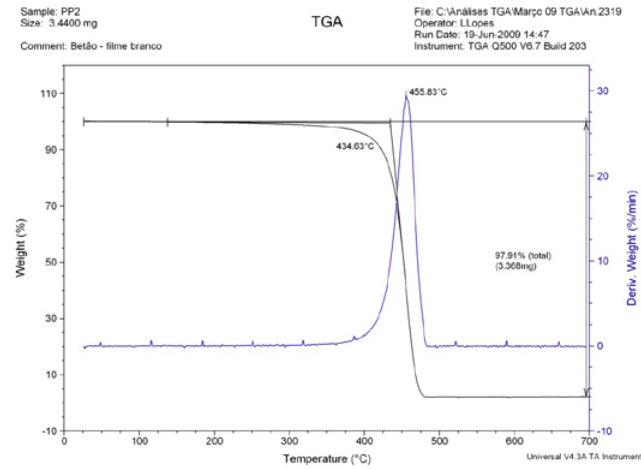
FIGURE 8 - Thermogravimetry of Group 3 also showing the beginning of decomposition and the peak value.